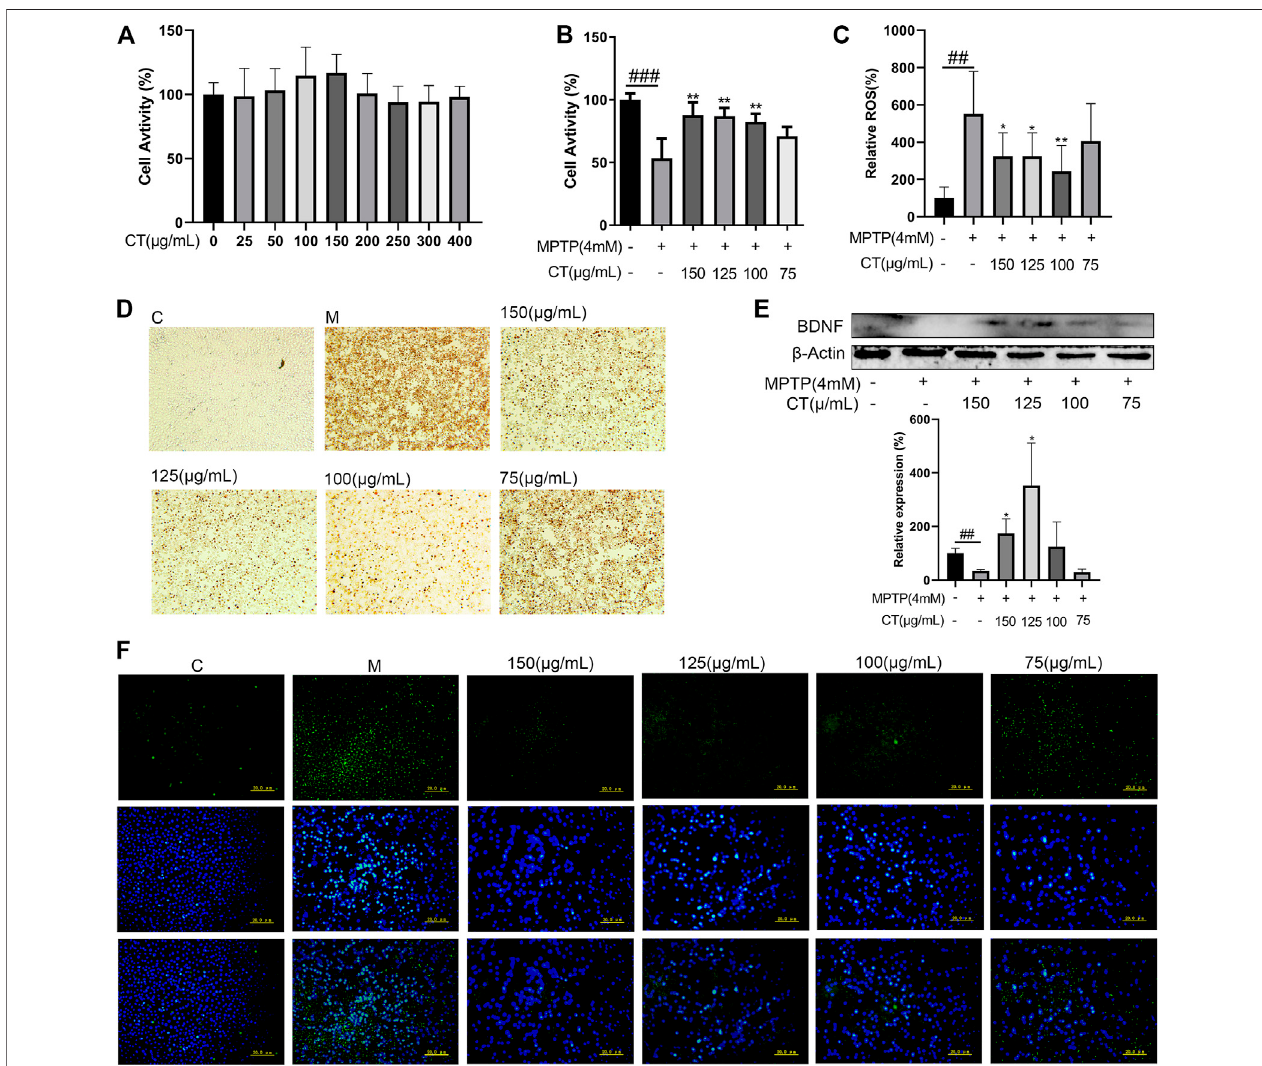
FIGURE 6 | Neuroprotective effects of the CT extract. (A,B) Protective effects of CT on cell viability of SH-SY5Y without or with MPTP stimulation. (C,F) Effects of CTonintracellularROSlevel. (D) EffectsofCToncellapoptosisbyTUNELassay. (E) EffectsofCTonproteinexpressionlevelofBDNFinMPTP-inducedSH-SY5Ycells. Data were shown as mean ± SD ( n = 3). # p < 0.05, ## p < 0.01, ### p < 0.001 when compared with the control group. * p < 0.05, ** p < 0.01 when compared with the MPTP-induced model